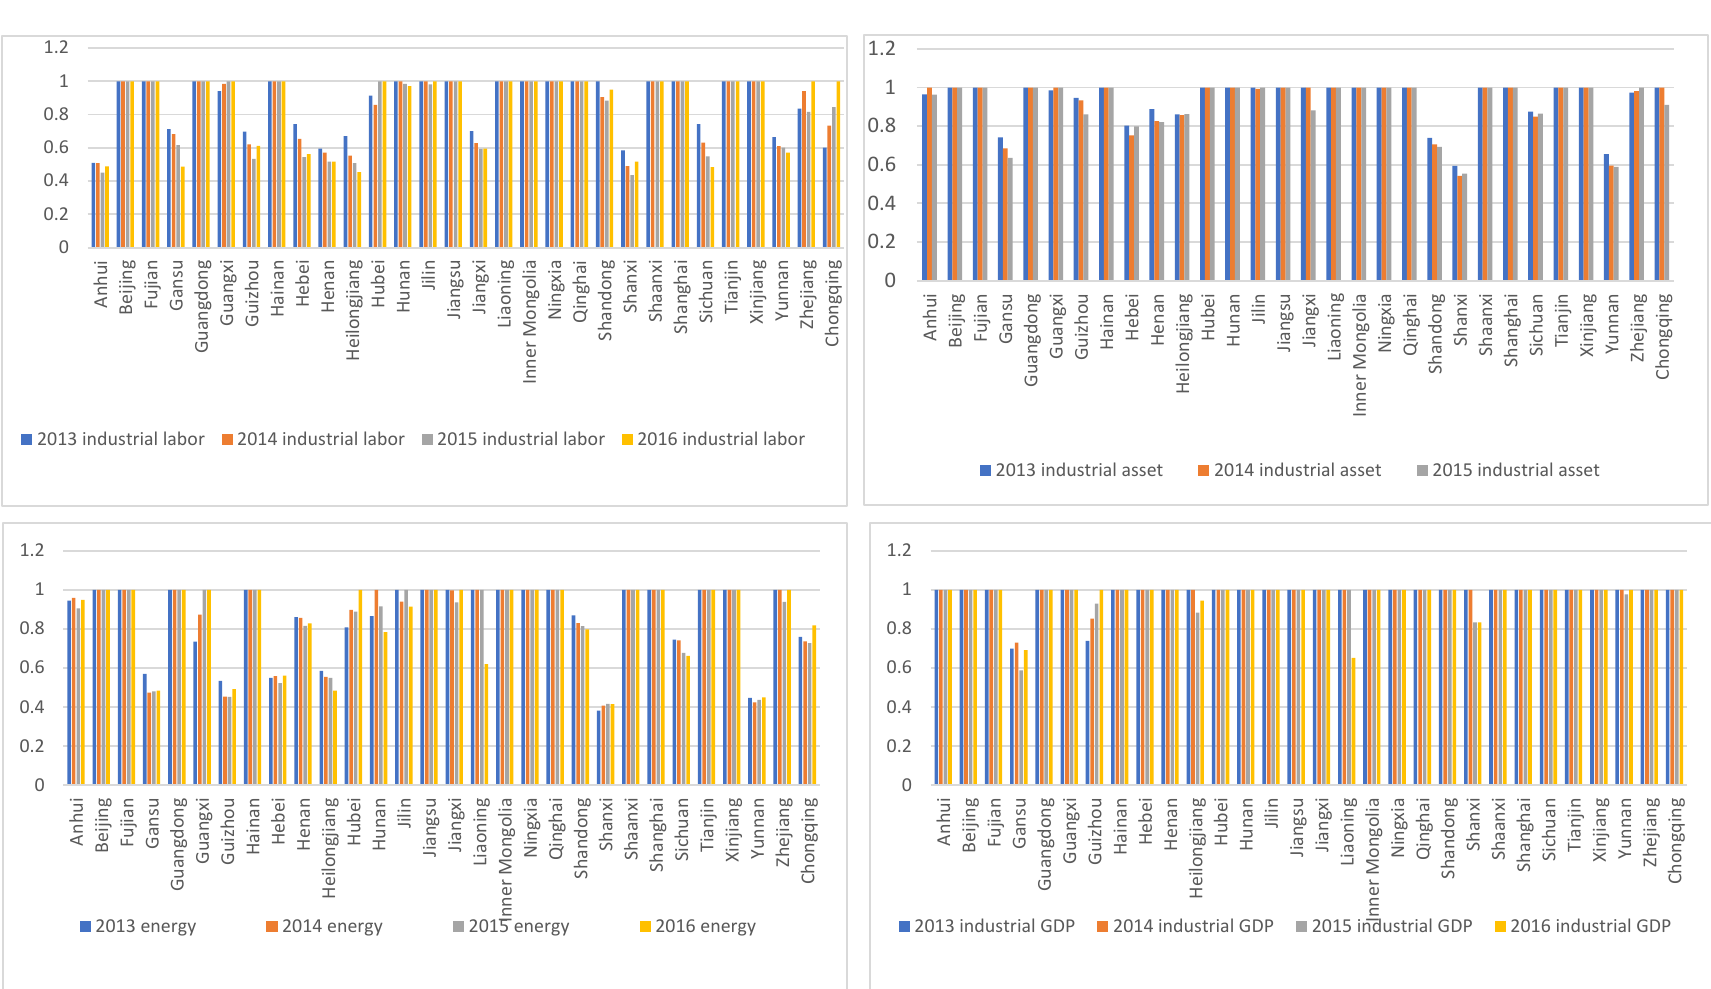
Figure A1. Efficiency of the second stage input-output indicator in 2013–2016. Figure A1. E ffi ciency of the second stage input-output indicator in